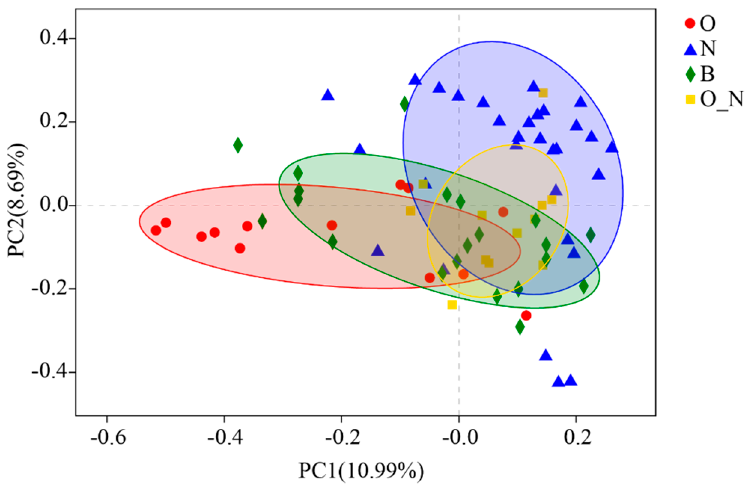
Figure 5. Principal coordinate analysis (PCoA) scores plot of beta diversity.